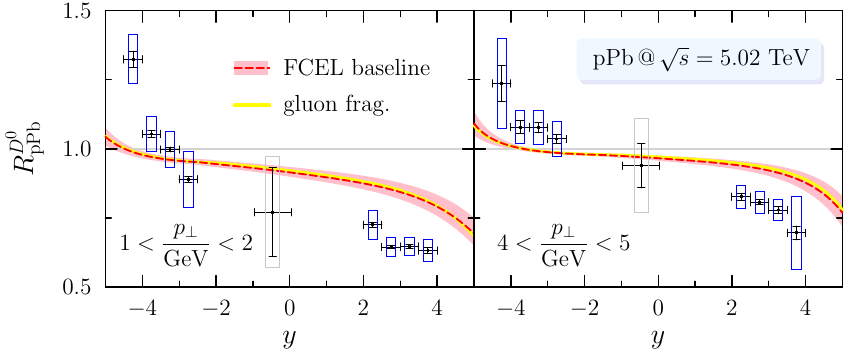
√ s = 5 . 02 TeV is shown for two